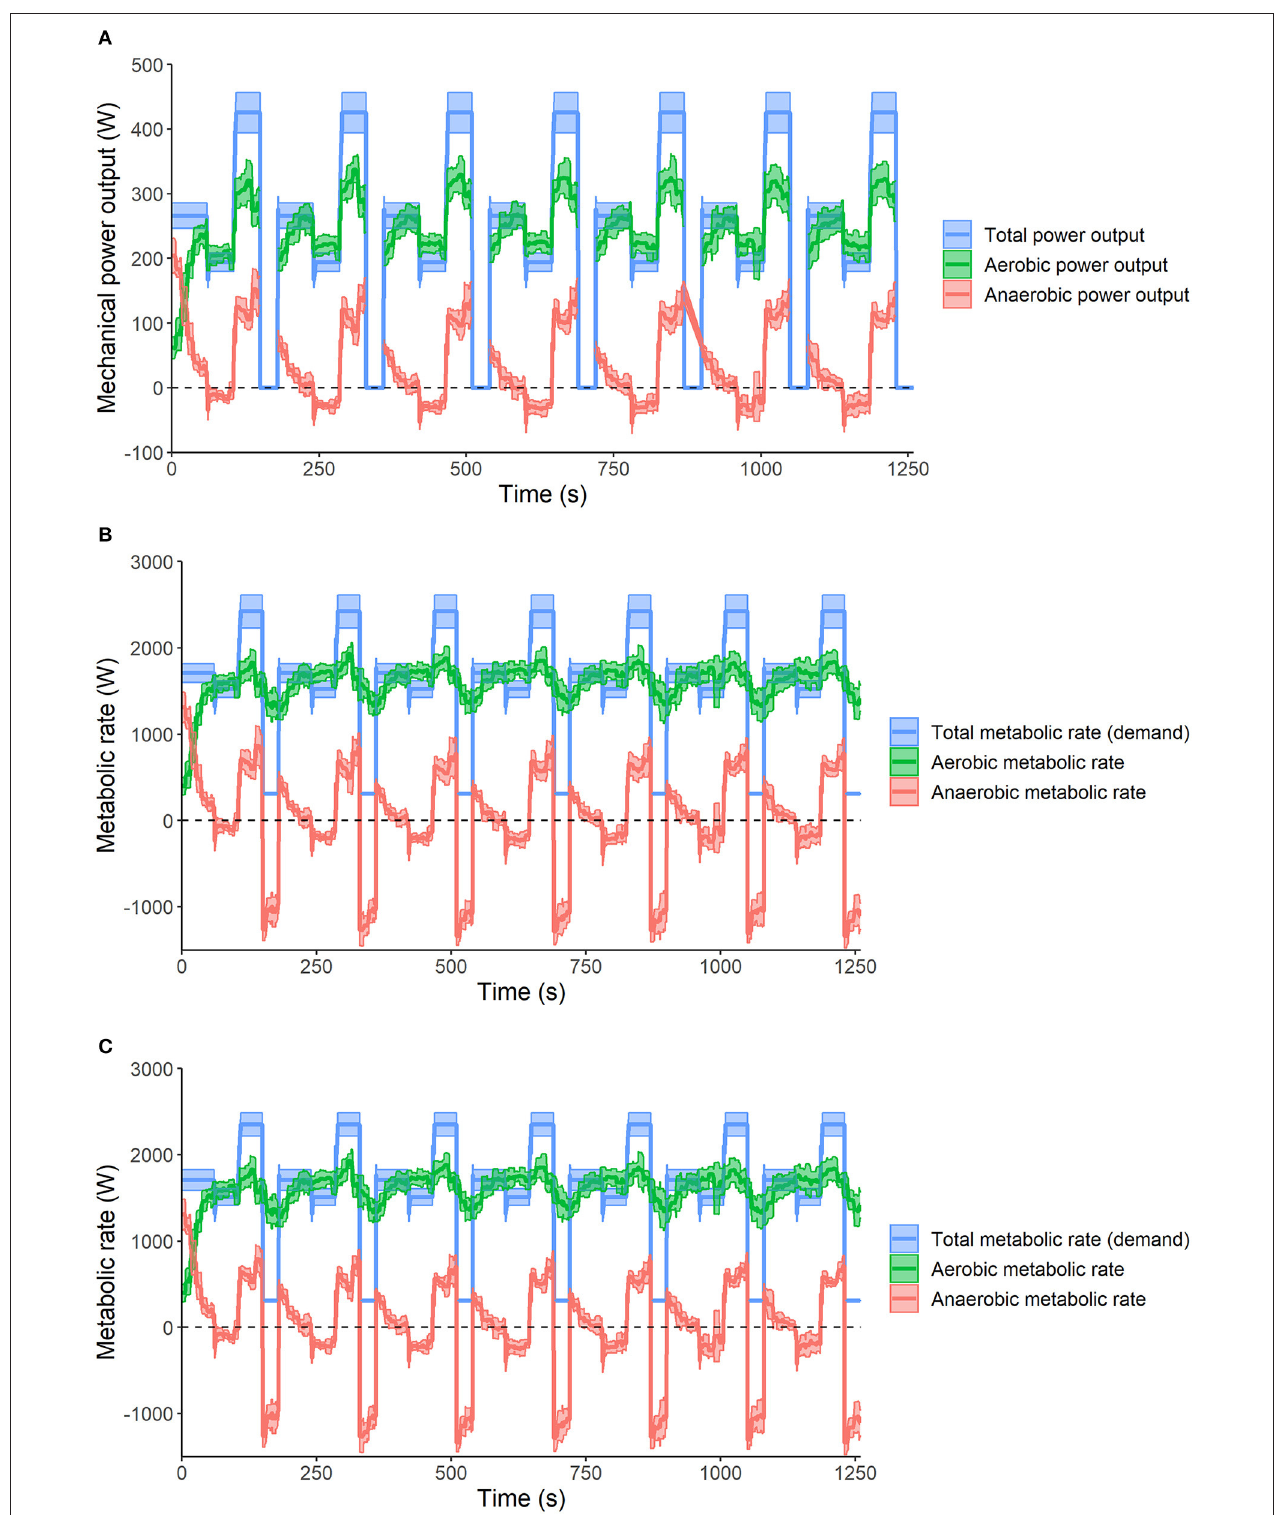
FIGURE 2 | The aerobic and anaerobic energy contributions calculated using the GE method (A) , 4-Y MAOD method (B) and 4 + Y MAOD method (C) during the simulated mass-start competition (without the final all-out sprint). (A) The aerobic and anaerobic energy contributions have not been determined during the simulated